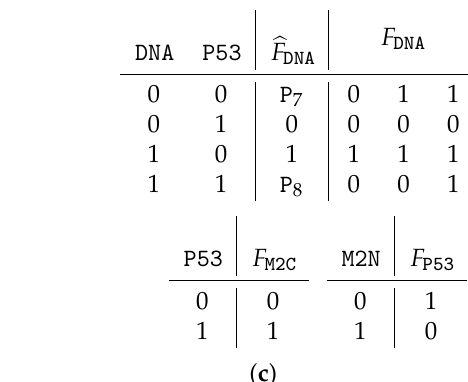
, . (cid:7) , (cid:78) , { ♠ ♣} = (cid:7) [ P 6 = [ P 8 , (cid:78) = (cid:7) [ P 3 1 ] , 1 ] , and 0 ] . The unla- } (cid:55)→ ♠ (cid:55)→ ♣ ♠ (cid:55)→